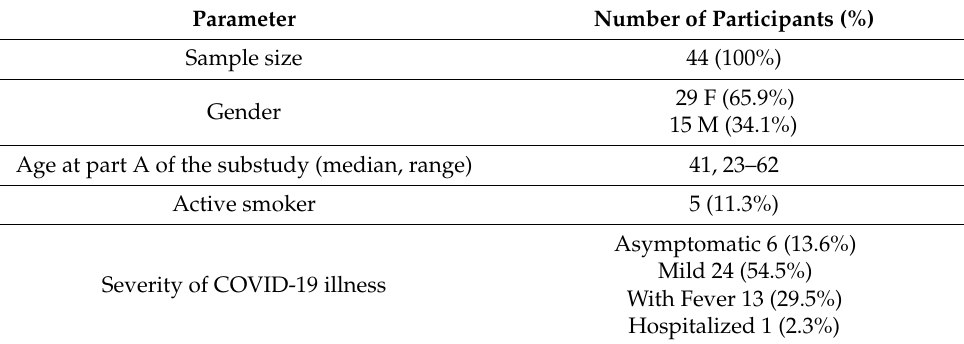
Table 1. Demographic and anamnestic information about the cohort of the